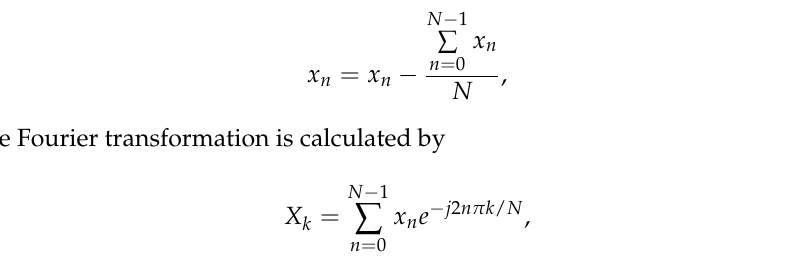
Figure 8. The p – q trajectories of the fractional-order map. ( a ) p – q trajectories of r = 17; ( b ) the p – q trajectories of r = 19.8; ( c ) p – q trajectories of 0 < x n < 0.2; ( d ) p – q trajectories of 0.8 < x n < 1.